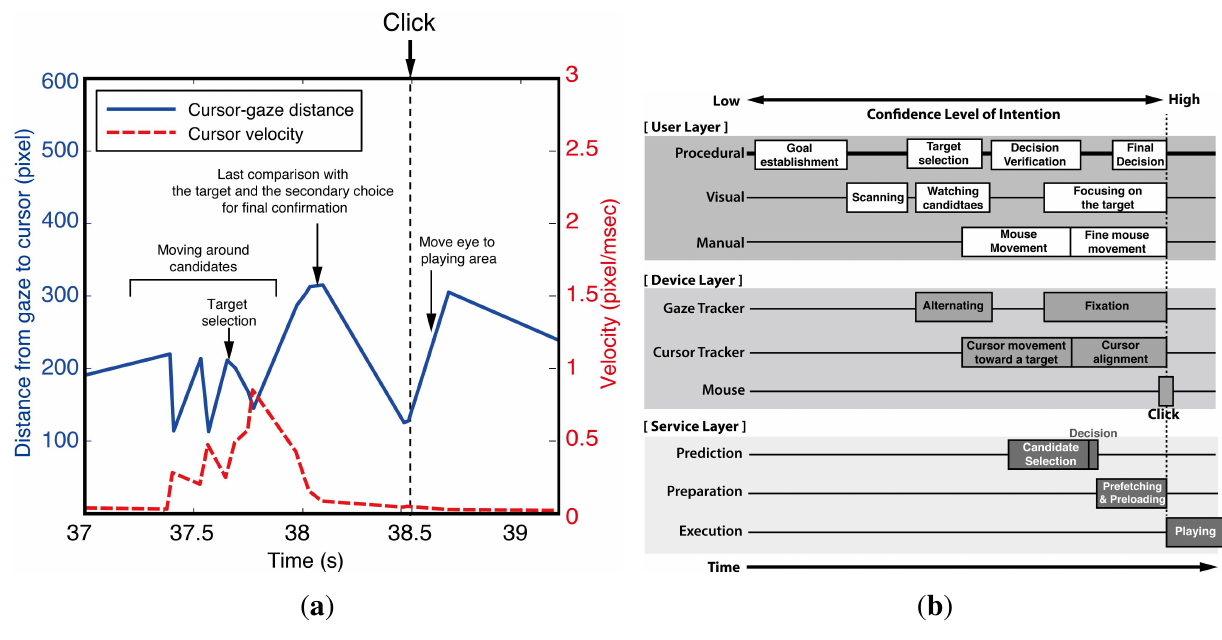
Figure 4. ( a ) An example of the cursor and gaze behavior; ( b ) the proposed threaded interaction model for user intention prediction in web video